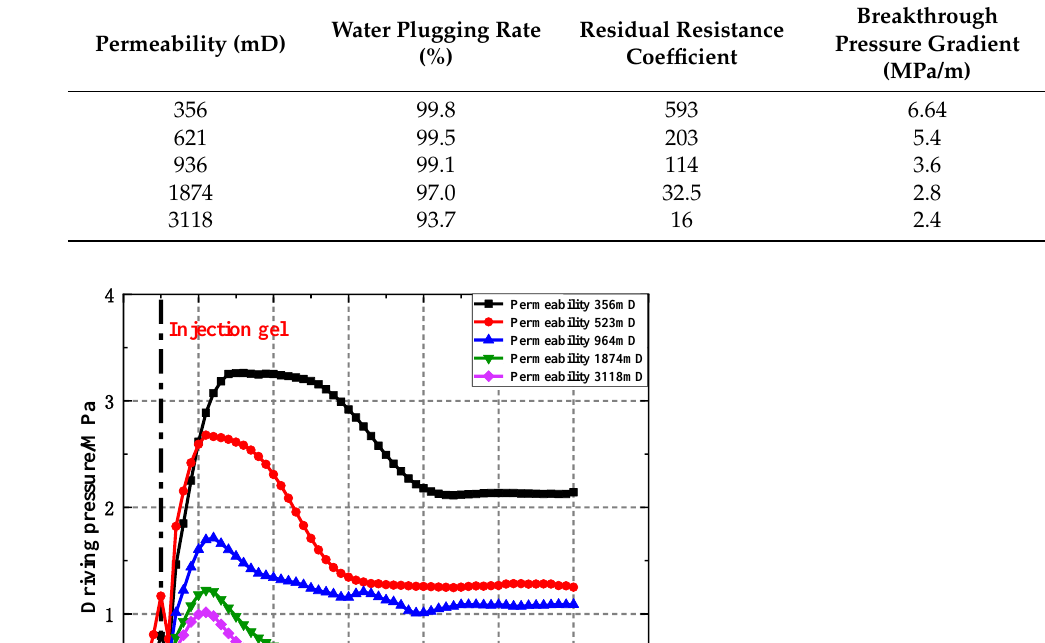
Table 8. Effects of permeability on the water plugging rate and the residual friction coefficient.